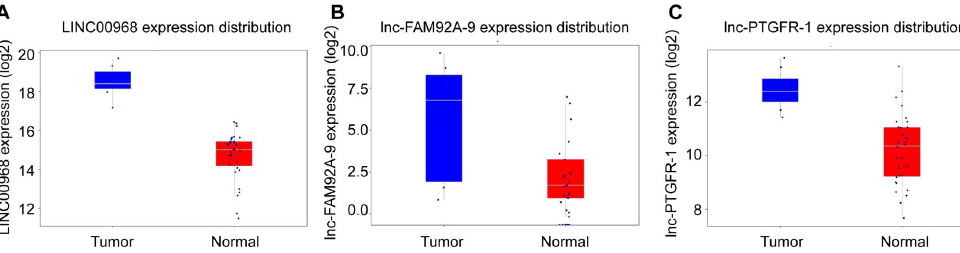
Fig 3. Box plot of lncRNAs differentially expressed in NSCLC tissues and adjacent tissues. A. The expression of LINC00968 in NSCLC tissues and adjacent tissues. B. The expression of lnc-FAM92A-9 in NSCLC tissues and adjacent tissues. C. The expression of lnc-PTGFR-1 in NSCLC tissues and adjacent tissues. The abscissa represented the group and the ordinate represented the expression of lncRNA, p < 0.05.